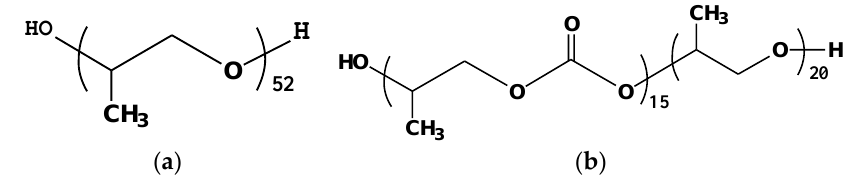
Figure 1. Structures of IED-1 ( a ) and IED-2 ( b ).